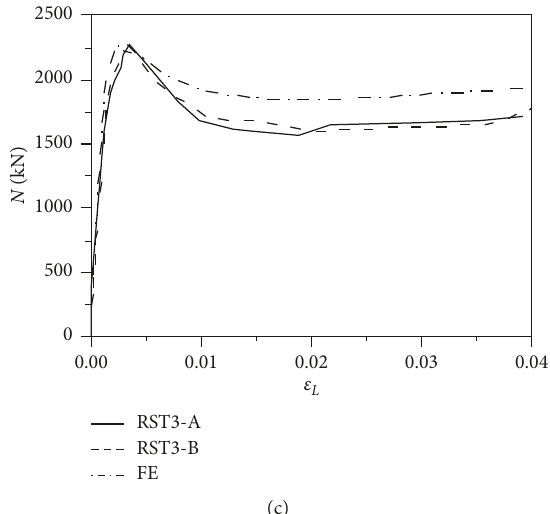
Figure 8: Comparison of N - Δ curves obtained from numerical and experimental studies. (a) RST1, (b) RST2, and (c) RST3.